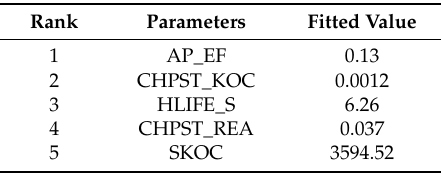
Table 6. Sensitive parameters of the SWAT pesticide